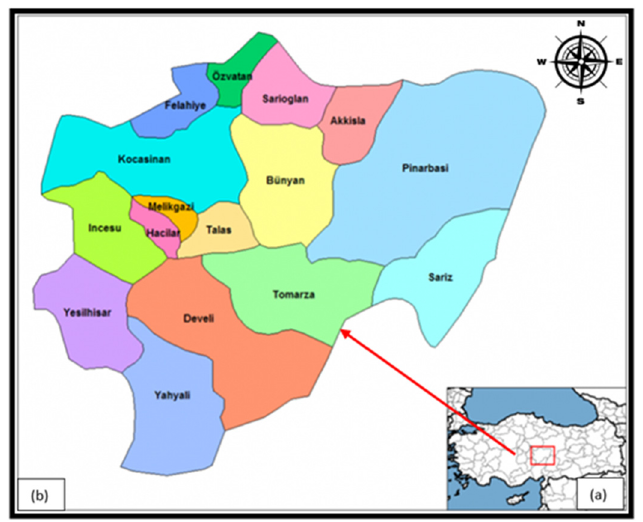
Figure 1. ( a ) Turkey map and location of Kayseri Province; ( b ) districts of Kayseri